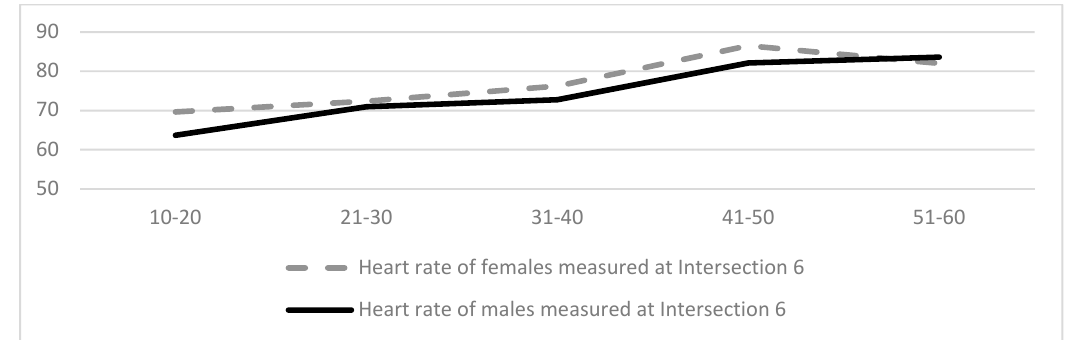
Figure 5. Heart rate increases with age, as shown by studies conducted by us.